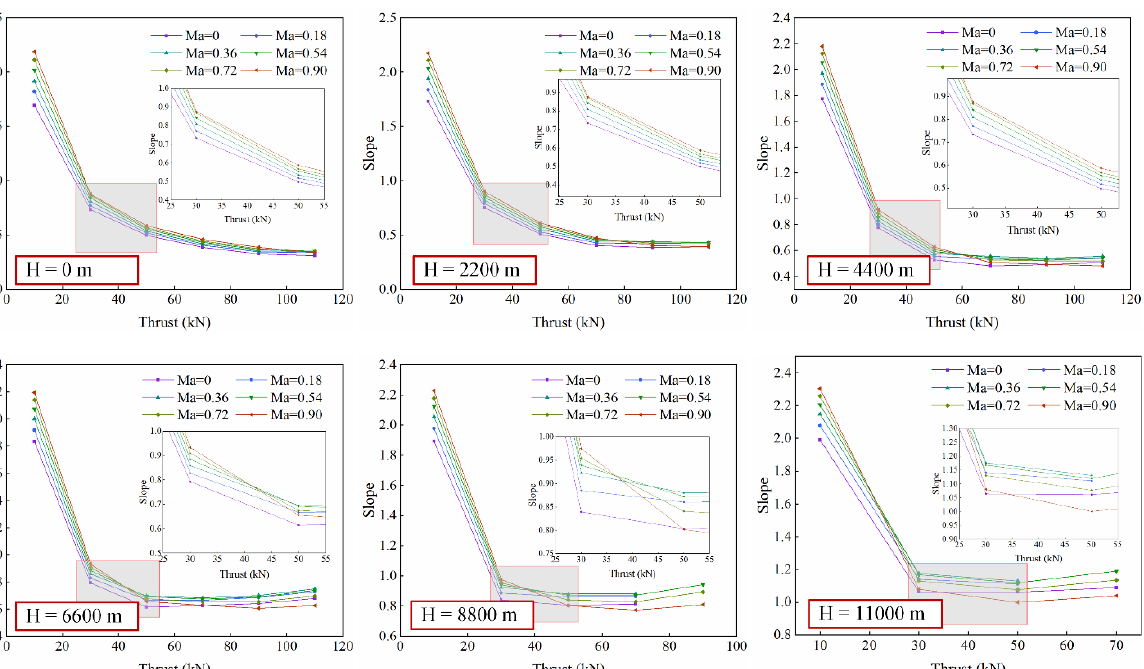
Figure 6. Influence of electric power extraction on the slope of the fitted line.